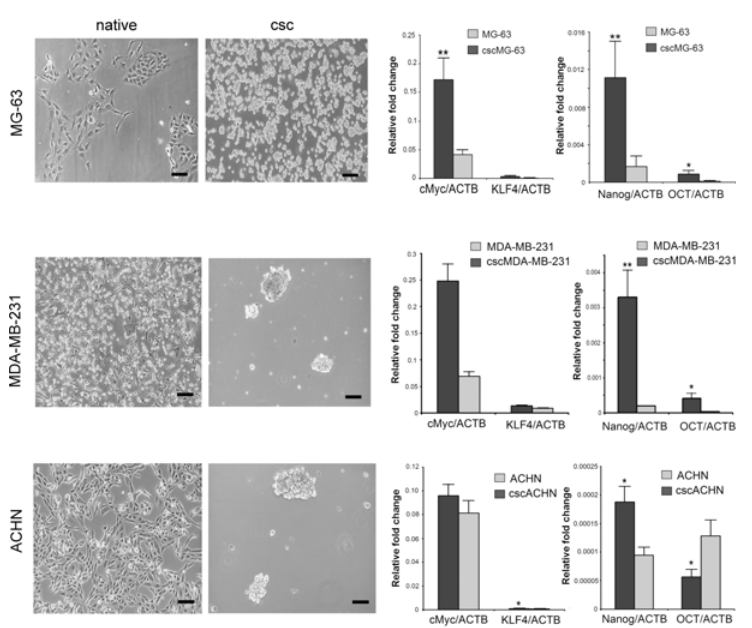
Fig 1. Characterization of sarcospheres obtained from MG-63. Representative images of adherent native cells and CSC floating spheres observed by inverted optical microscope for the different cell lines (scale bar 100 μ m, left panel), and gene expression of stem cell markers by qRT-PCR (right panel). Normalization to ACTB. For cscMG-63, c-Myc ** p = 0.0019, KLF4 p = ns, Nanog ** p = 0.0010, OCT3/4 * p = 0.0265. For cscMDA-MB-231, c-Myc ** p = 0.0011, KLF4 * p = 0.0130, Nanog ** p = 0.0011, OCT3/4 * p = 0.0325. For cscACHN, c-Myc p = ns, KLF4 * p = 0.0130, Nanog * p = 0.0130. For adherent ACHN, OCT3/4 * p = 0.0130. (n = 6 –